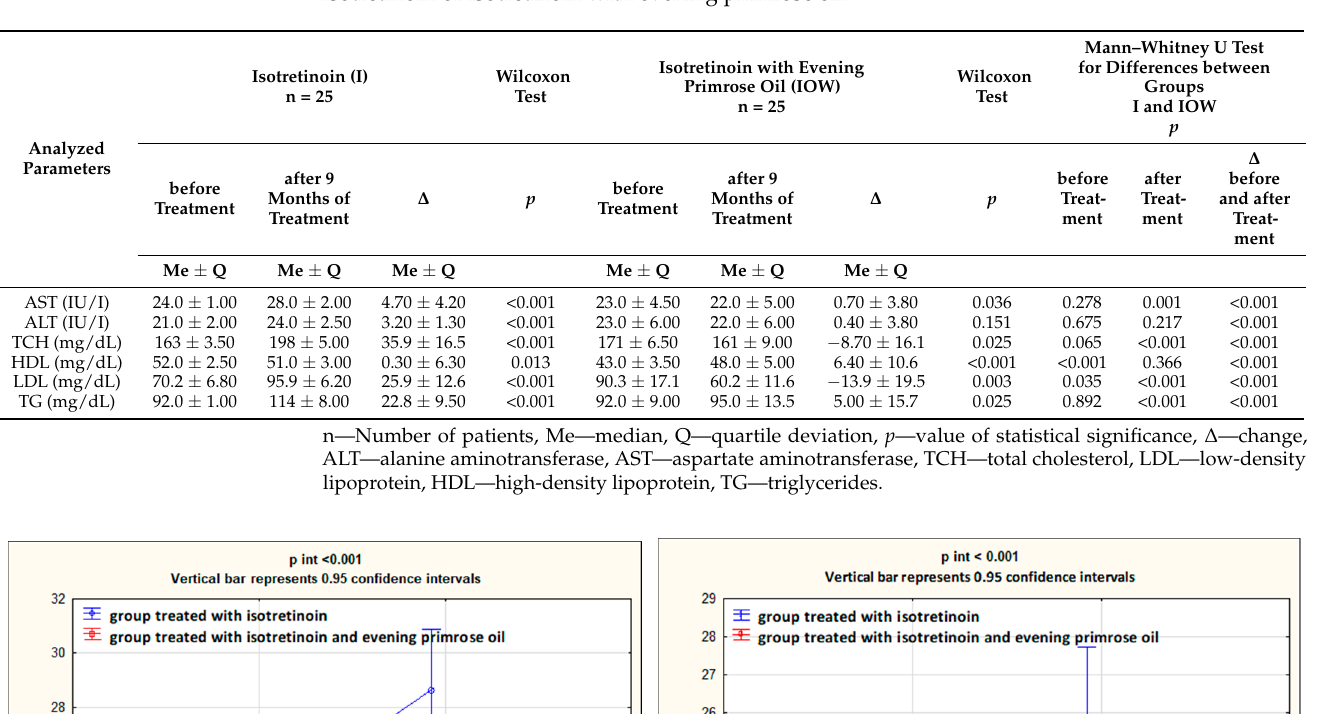
Table 3. Changes in ALT, AST, TCH, LDL, HDL, and TG levels or concentrations in groups using isotretinoin or isotretinoin with evening primrose oil.